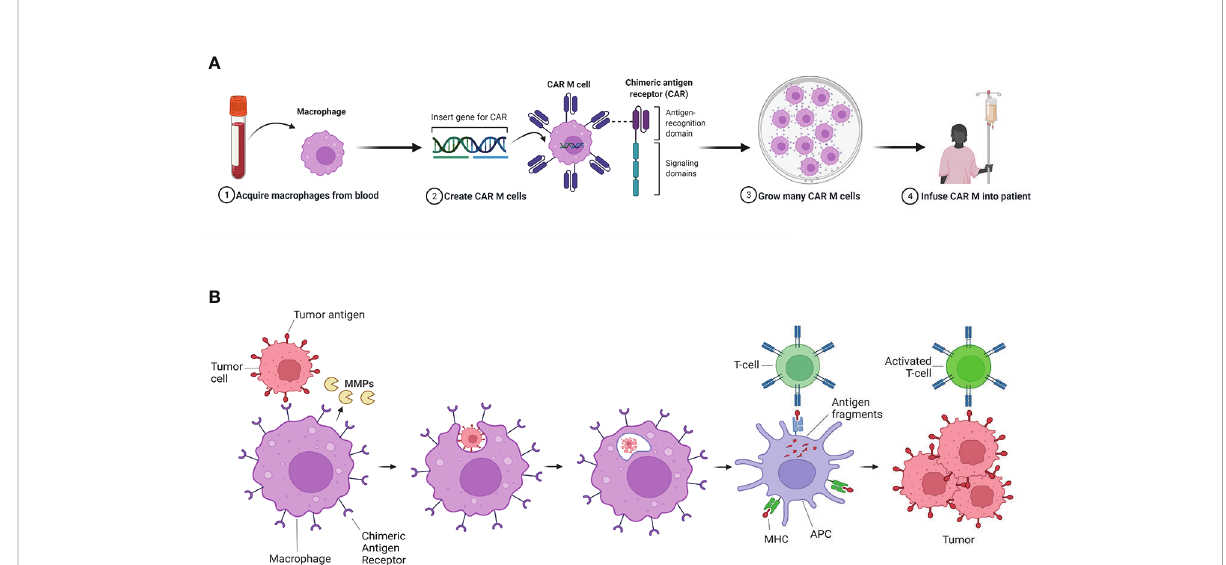
FIGURE 3 CAR-M activity in breast cancer. (A) Macrophages modi fi ed with Chimeric antigen receptor (CAR-M) present an improved phagocytic activity and antigen presentation capacity against tumors. CAR-M therapy is developed by the transfer of an edited speci fi c CAR gene into macrophages withdrawn from patient peripheric blood. (B) These genetically modi fi ed cells are then more effective in binding to the tumor cell surface via speci fi c antigen identi fi cation and active against tumor cells when reinfused into the patient. Furthermore CAR-M are able to produce metalloproteinases (MMPs) that can degrade part of the extracellular matrix (ECM) components in the tumor stroma. This activity facilitate penetration of anti-tumor immune cells into the tumor. Adapted from “ Car T Cell Therapy Overview ” , by BioRender.com (2022). Retrieved